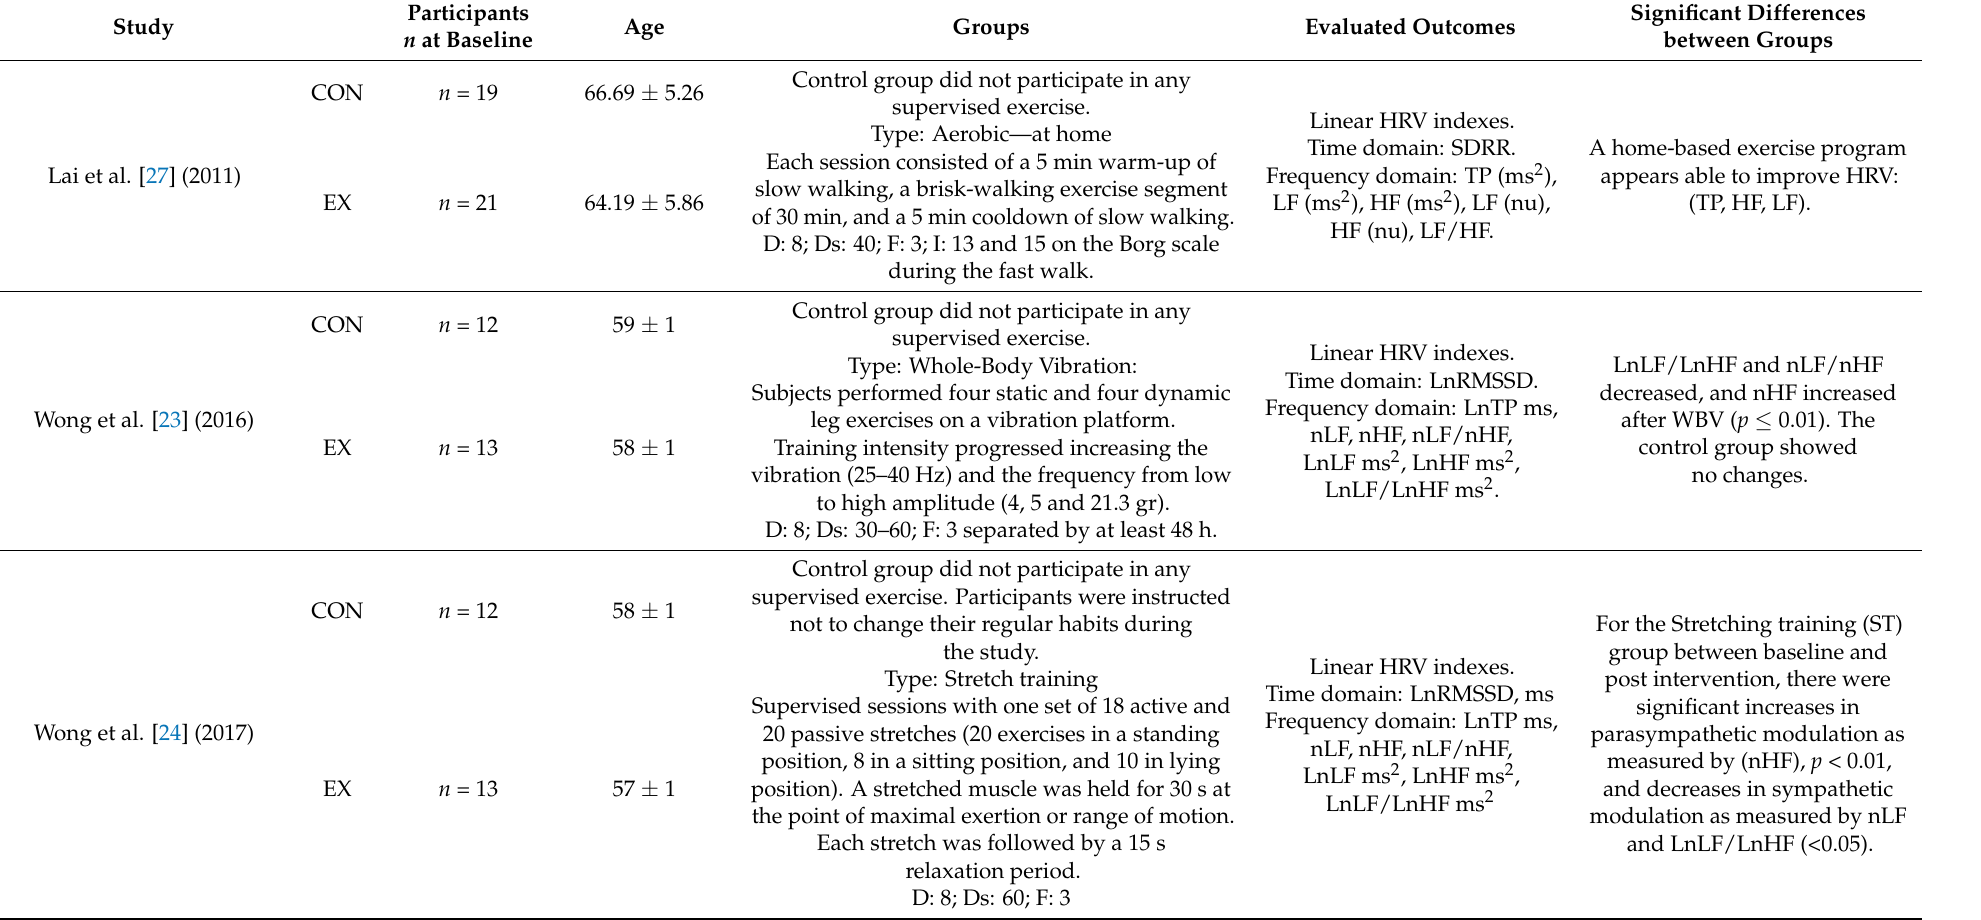
Table 3. Effect of physical exercise and HRT on cardiovascular and metabolic system in postmenopausal